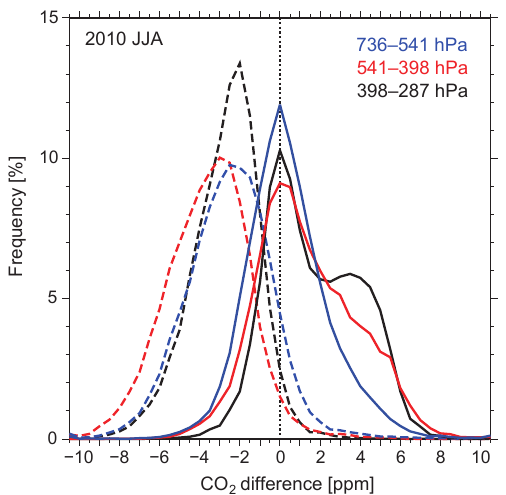
Figure 8. Same as Fig. 7, but showing frequency distributions dur- ing the JJA season of 2010 on 736–541hPa (retrieval layers 3–4), 541–398hPa (retrieval layers 5–6), and 398–287hPa (retrieval lay- ers 7–8). Black, red, and blue lines indicate the results on 398–287, 541–398, and 736–541hPa, respectively.